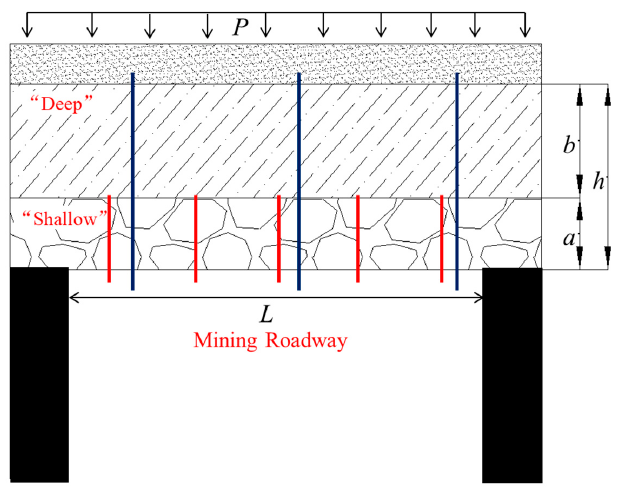
Figure 8. Layered grouting support structure.